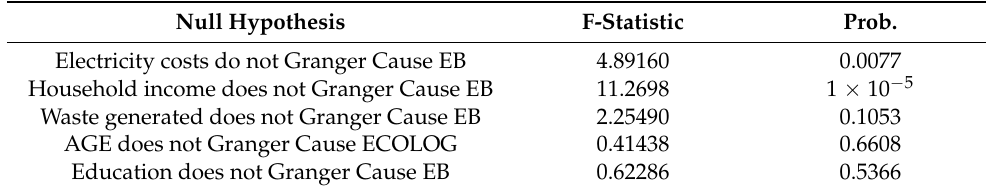
Table 4. Pairwise Granger causality